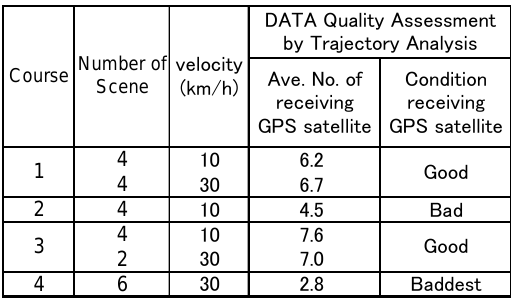
Table 1. Summary of measurement paths / courses